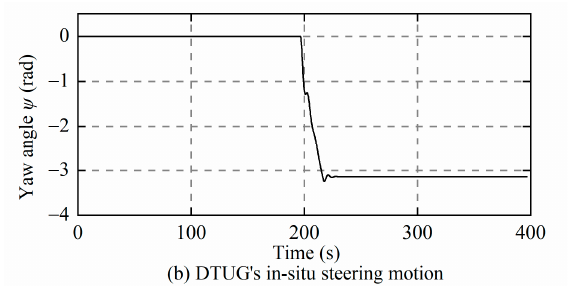
Figure 9. Steering motion of DTUG and LUNA.